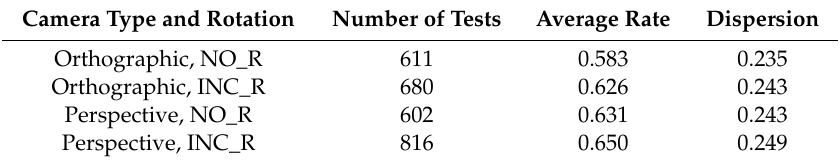
Table A9. Numerical results of the users regarding the camera type and camera rotation.